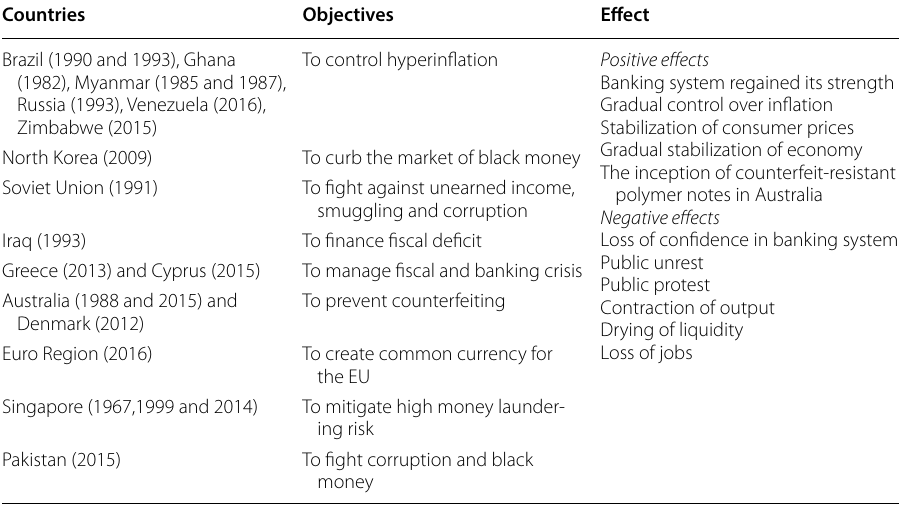
Table 1 Global experience on demonetization. Source: Government of India (2017) Countries Objectives Effect Brazil (1990 and 1993), Ghana To control (1982), Myanmar (1985 and 1987), Russia (1993), Venezuela (2016), Zimbabwe (2015)